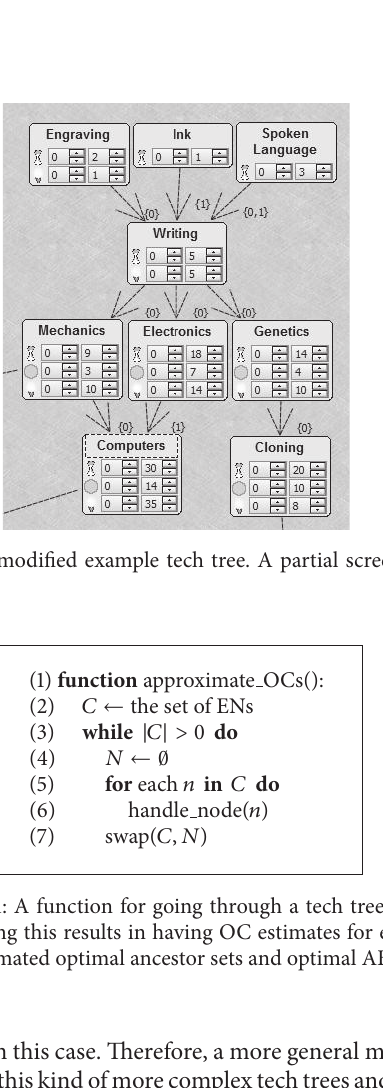
Algorithm 1 as the pseudocode function approximate OCs.